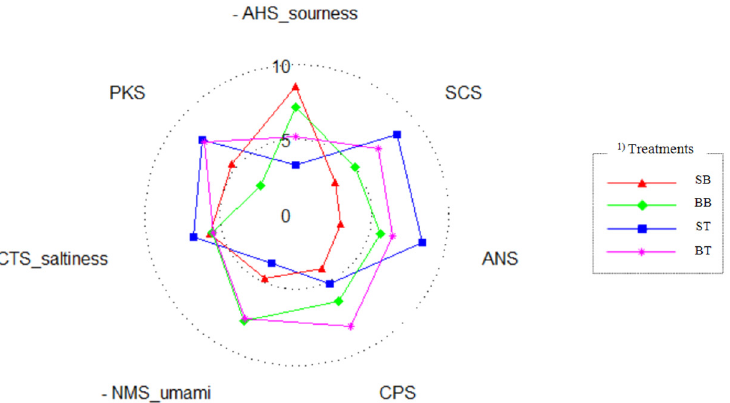
Figure 2. Changes in organoleptic characteristics detected using an electronic tongue on the breast BT, broilers and thigh of spent hens and broilers. SB, spent hens breast; BB, broilers breast; ST, spent hens thigh; BT, broilers thigh.